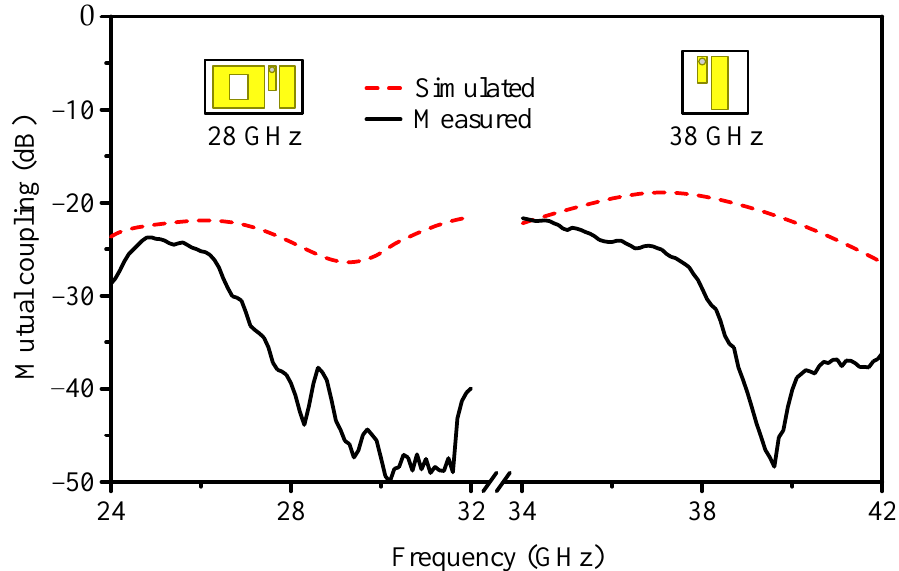
Figure 7. Mutual coupling between adjacent elements of the two antenna arrays.